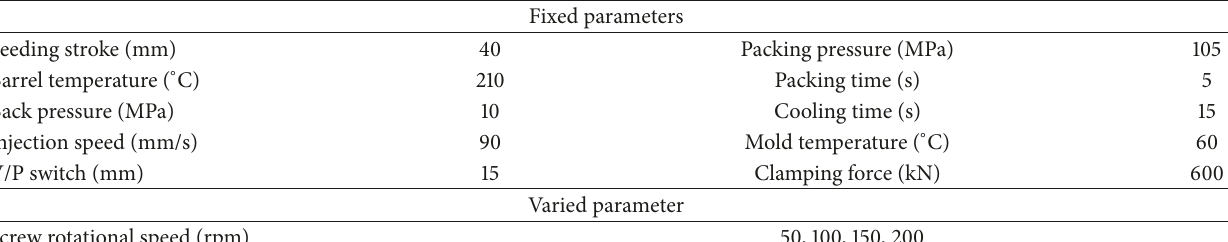
Table 9: Process parameter settings for varied screw rotational speed